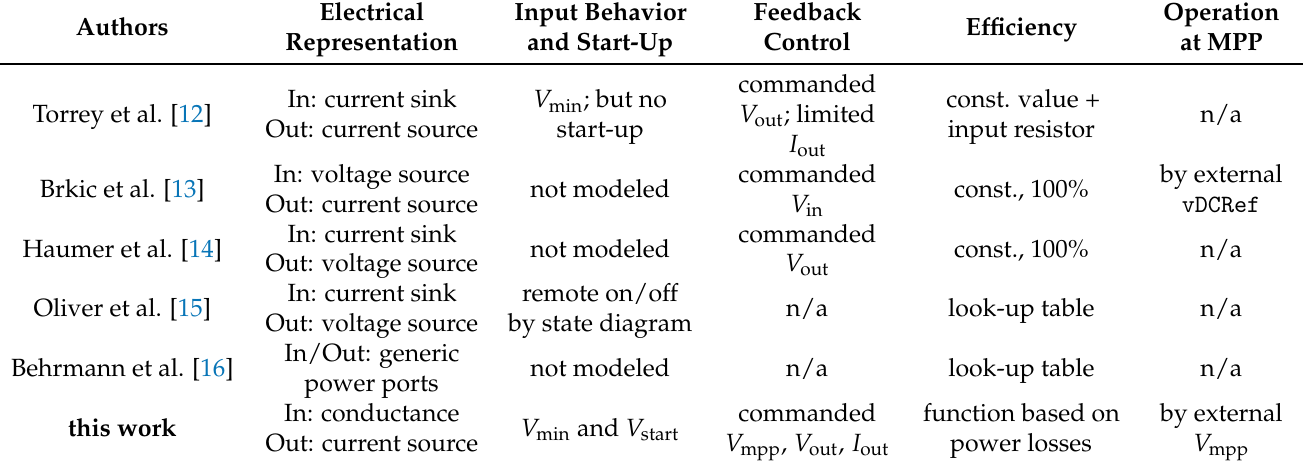
Table 1. Comparison of state-of-the-art models of behavioral DC/DC